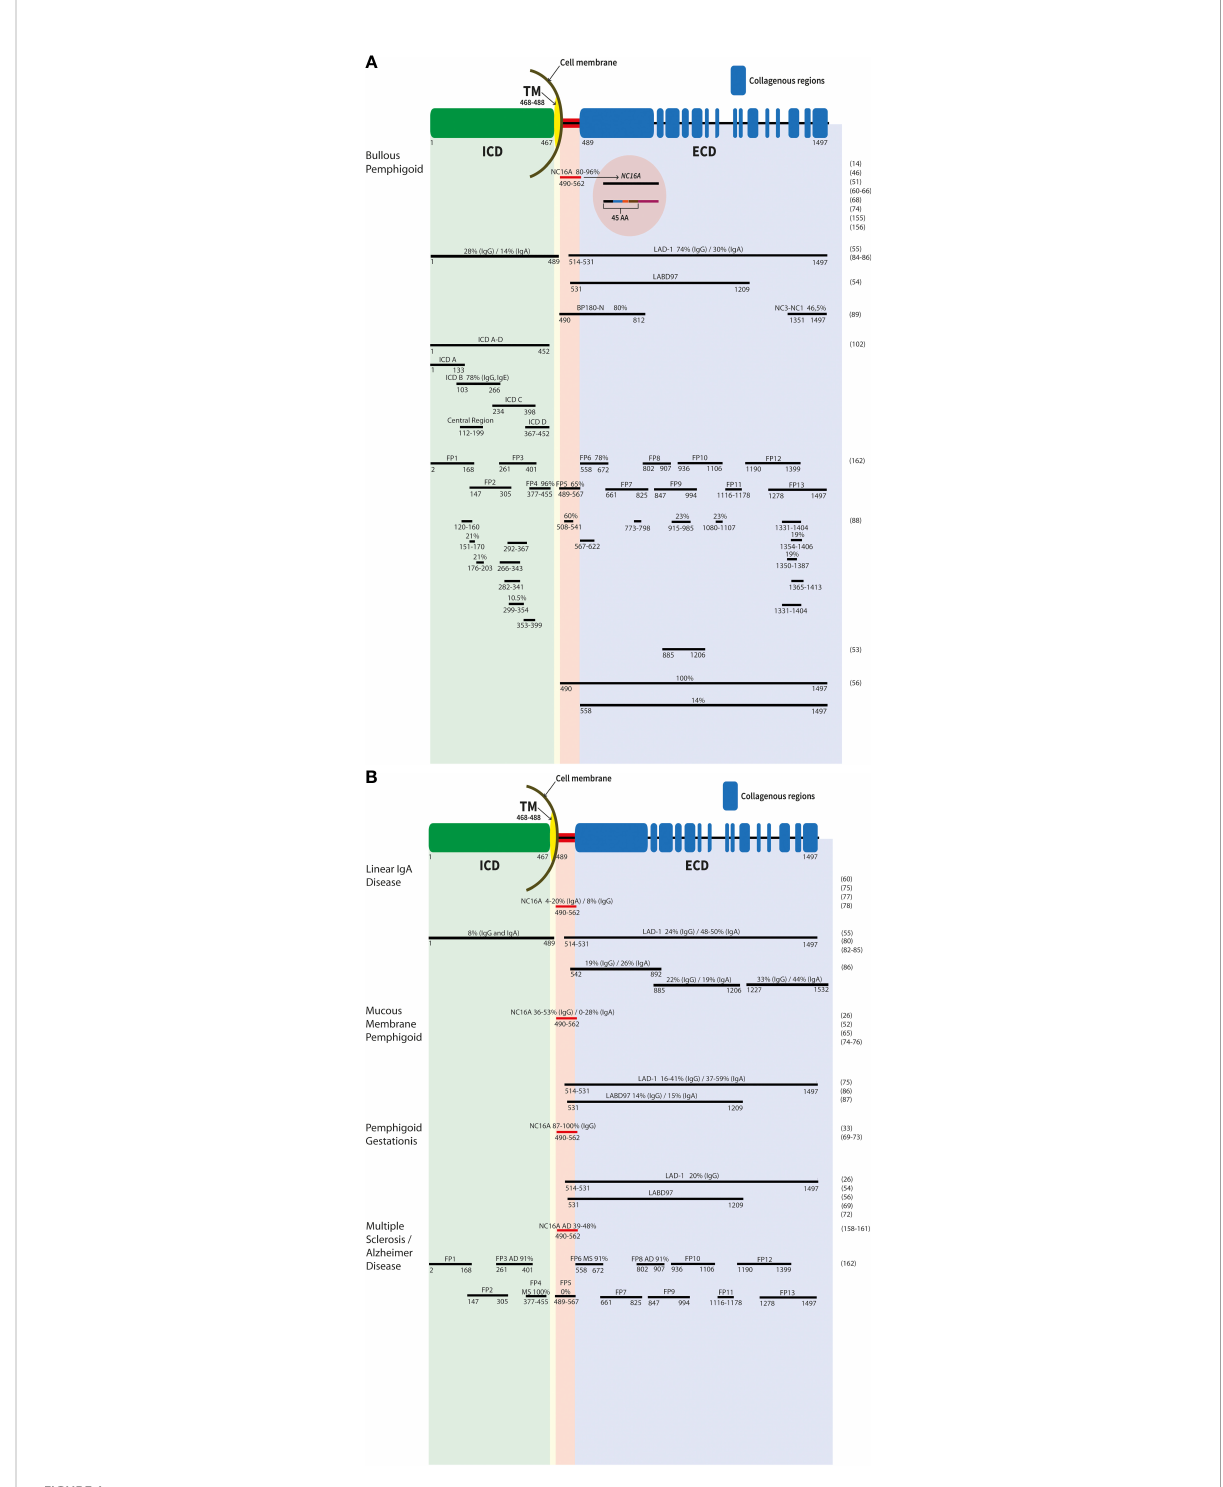
FIGURE 1 Schematic representation of the antigenic sites of the BP180 protein. The different epitopes of the molecule are shown. Numbers represent the fi rst and last amino acid of each fragment/recombinat protein. The common names are listed above. The main targets are labelled with antibody reactivity (%) and IgG if not otherwise mentioned. Results in bullous pemphigoid (A) , linear IgA disease, mucous membrane pemphigoid, pemphigoid gestationis, as well multiple sclerosis and Alzheimer ’ s disease (B) are depicetd. ECD, extracellular domain; ICD, intracellular domain; TM, transmembrane